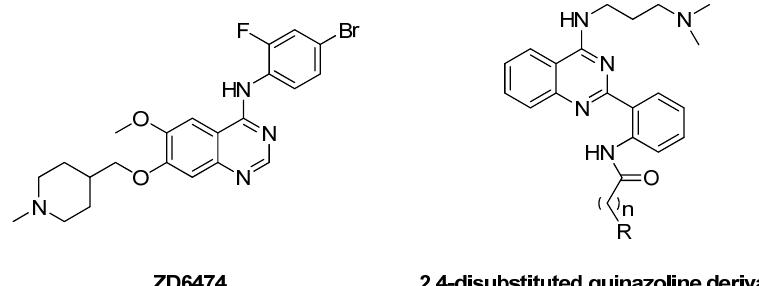
Figure 1. Structure of ZD6474 and 2,4-disubstituted quinazoline